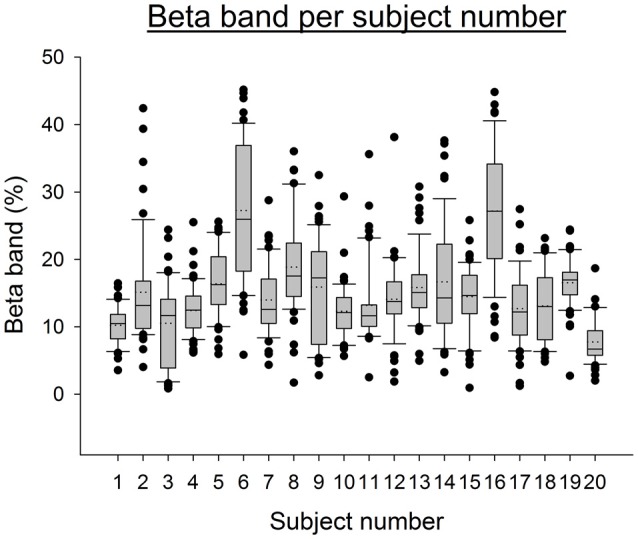
Boxplot representing the EEG Beta band for all electrodes and conditions per subject. The boxes correspond to the 25–75 percentiles, the continuous lines to the median values, the dotted lines to the mean values and the whiskers represent the 10 and 90 percentiles. The dots are the outlying values. Note the excess of Beta activity for subjects 6 and 16. The Beta band is expressed in percent of the complete spectrum (%). Z-scores for subject 6 and 16 are respectively: 5.86 and 5.82.